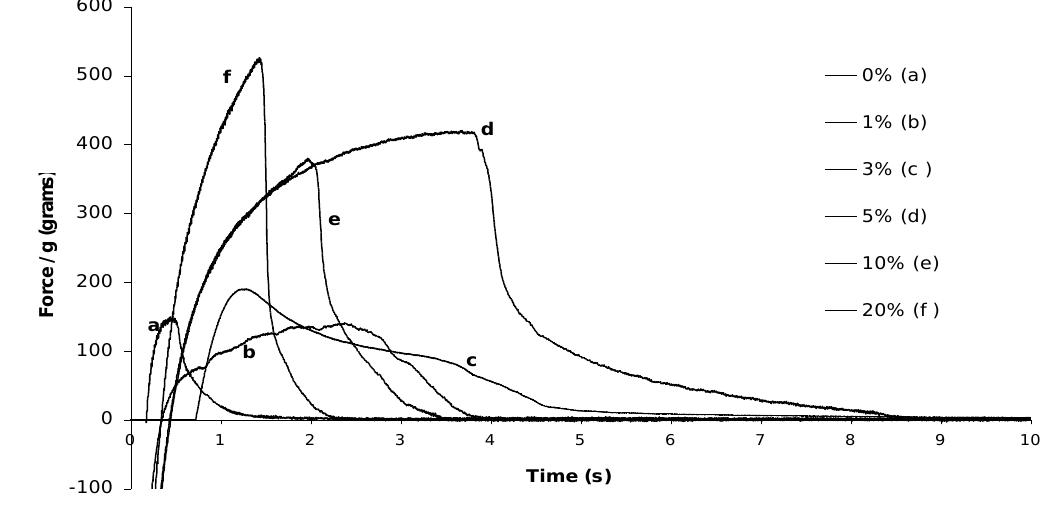
Figure 2. Probe-tack adhesion curves of Cementek with increasing amounts of SE16P (nylon probe).